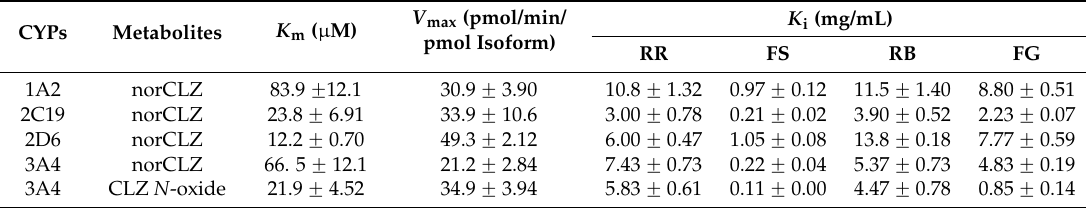
Table 3. Potency of the inhibitory effects of Radix Rehmanniae (RR), Fructus Schisandrae (FS), Radix Bupleuri (RB) and Fructus Gardeniae (FG) on CLZ metabolism in human recombinant cytochrome P450s a .